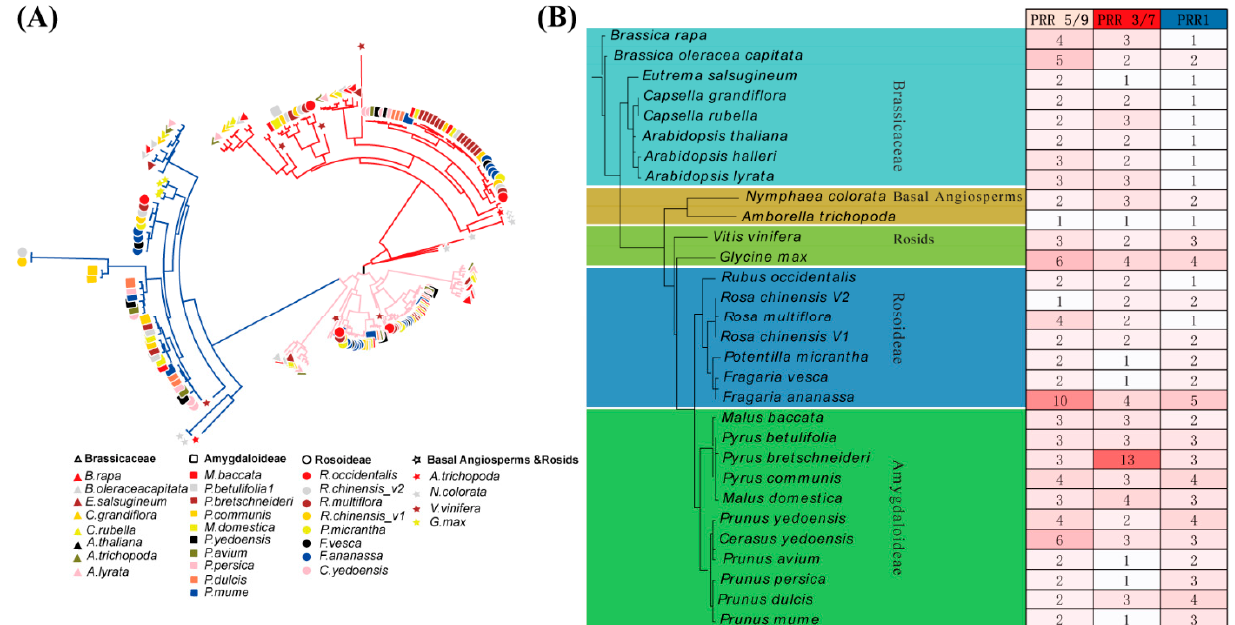
Figure 2. Phylogeny of clock PRR genes in Rosaceae. ( A ) Phylogenetic tree of all clock PRRs from 2 basal angiosperm species, 18 Rosaceae species, 8 Brassicaceae species, and 2 basal Rosids species. Clock PRRs of Rosaceae classified into three major clades on the basis of their phylogeny shown in different branch colors; ( B ) species tree constructed on the basis of clock PRRs phylogenetic relation and the number of clock PRRs in each clade of every species.